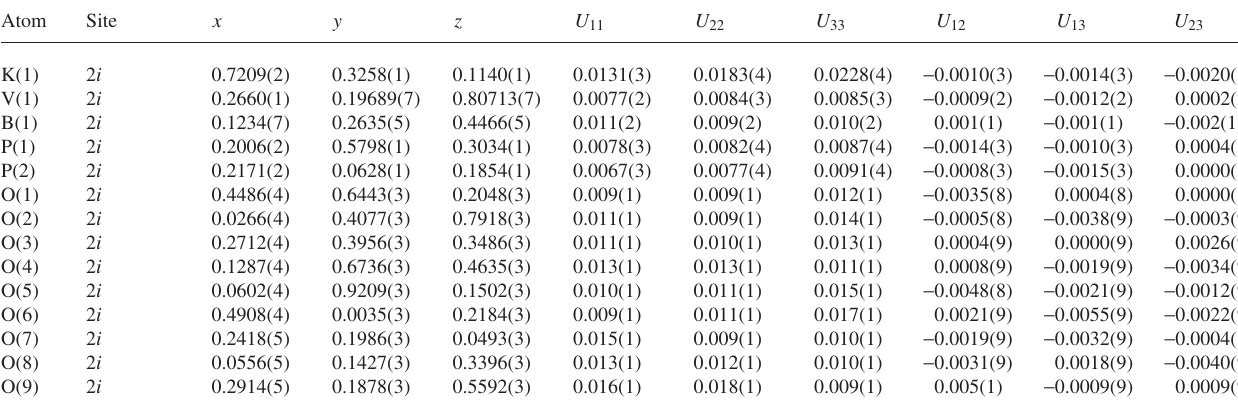
Table 3. Atomic coordinates and displacement parameters (in Å 2 )